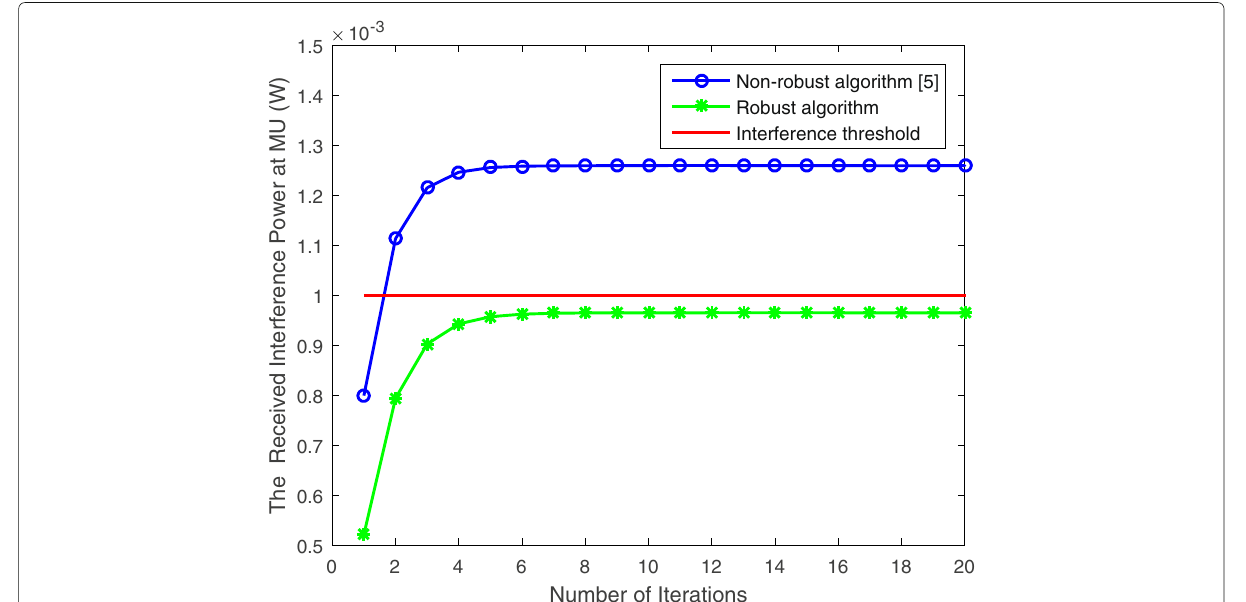
Fig. 4 Comparison of the interference power received at MU-Rx between robust and non-robust algorithm